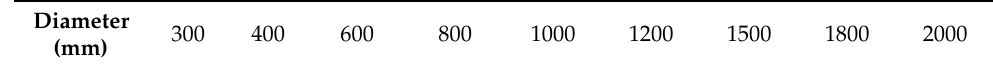
Table 4. Reduced range of